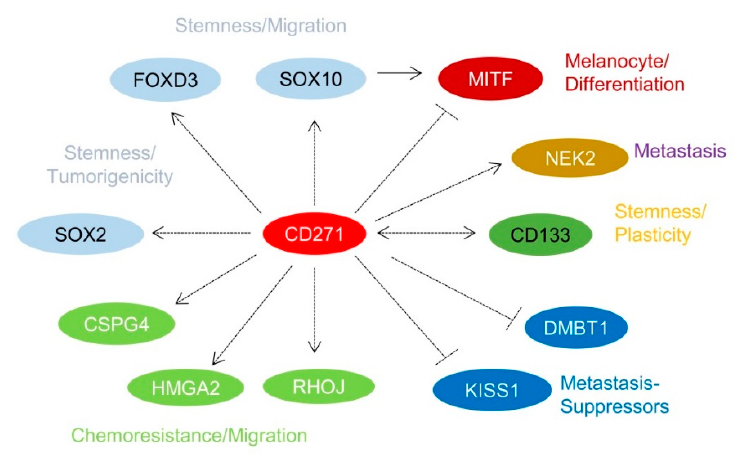
Figure 2. CD271 serves as regulator of basic properties of melanoma cells. Our knockdown study (GSE52456) uncovered several CD271-associated genes; some of them are depicted. Among them are mediators of stemness and migration of NCSCs, tumorigenicity, and chemoresistance, migration, and plasticity.